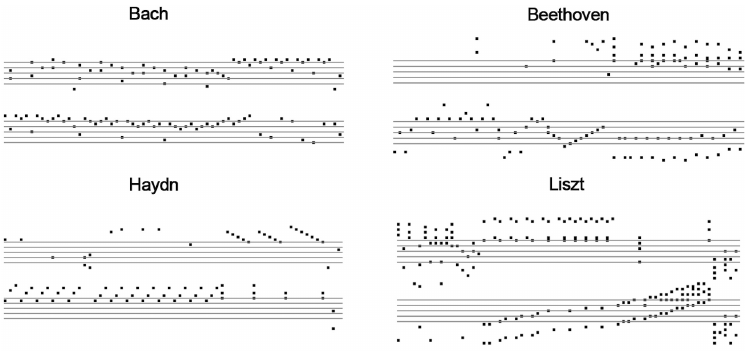
Figure 3. Several examples of fixed-length bootleg score